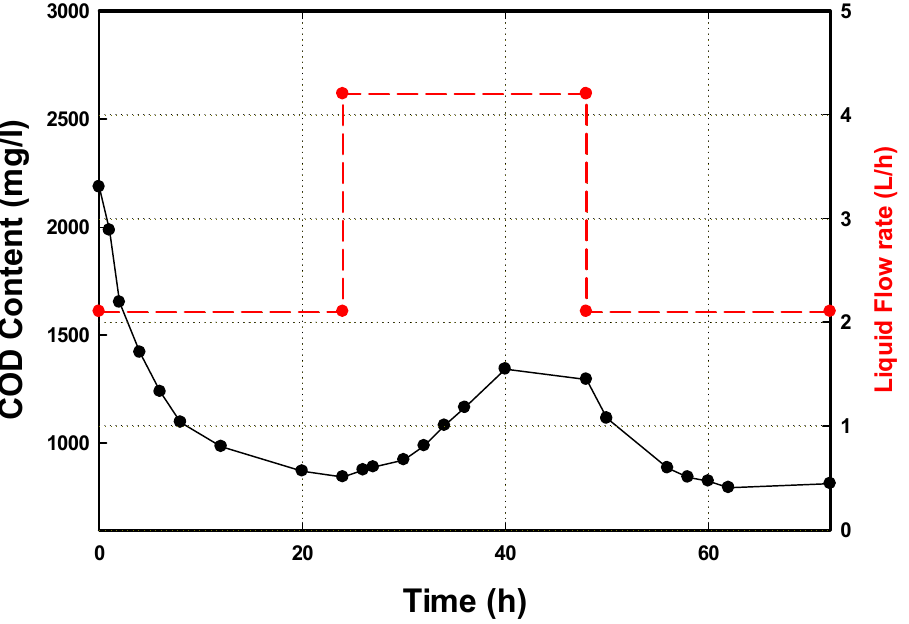
Figure 6. Liquid flow rate step-change of (2.1–4.5 and back to 2.1 mL/min). Initial COD = 2200 mg/L; temperature = 32 °C; air flow rate 3.3 L a /L r .min.